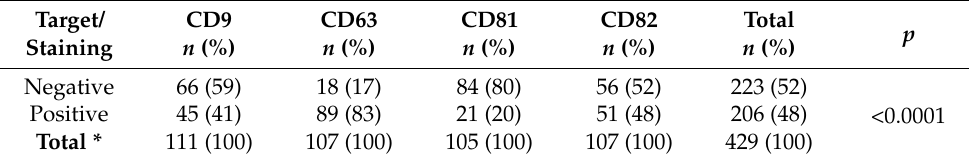
Figure 1. The TSPAN gene and semi-quantitative protein expression profile in VSCC samples. ( a ) Frequency (%) of tissue samples with upregulation (FR > 1) of CD9, CD63, CD81, and CD82 ( n = 16). ( b ) Relative quantification of TSPAN expression in tumors samples compared to normal, tumor-free edges (tissue reference). Human hypoxanthine phosphoribosyltransferase (HPRT) was used as an internal reference. * p = 0.0035; *** p = 0.0006. ( c ) Frequency (%) of samples with positive protein expression ( n = 117). ( d ) Semi-quantitative expression analysis of TSPANs in VSCC samples (* p < 0.01; ** p < 0.001; *** p < 0.0001). Dotted lines indicate the cut off values for RT-PCR ( ≥ 1; a) and IHC ( ≥ 3, c) analyses. Table 2. Frequency of TSPANs immunohistochemical positive staining (moderate and strong) in VSCC samples ( n =